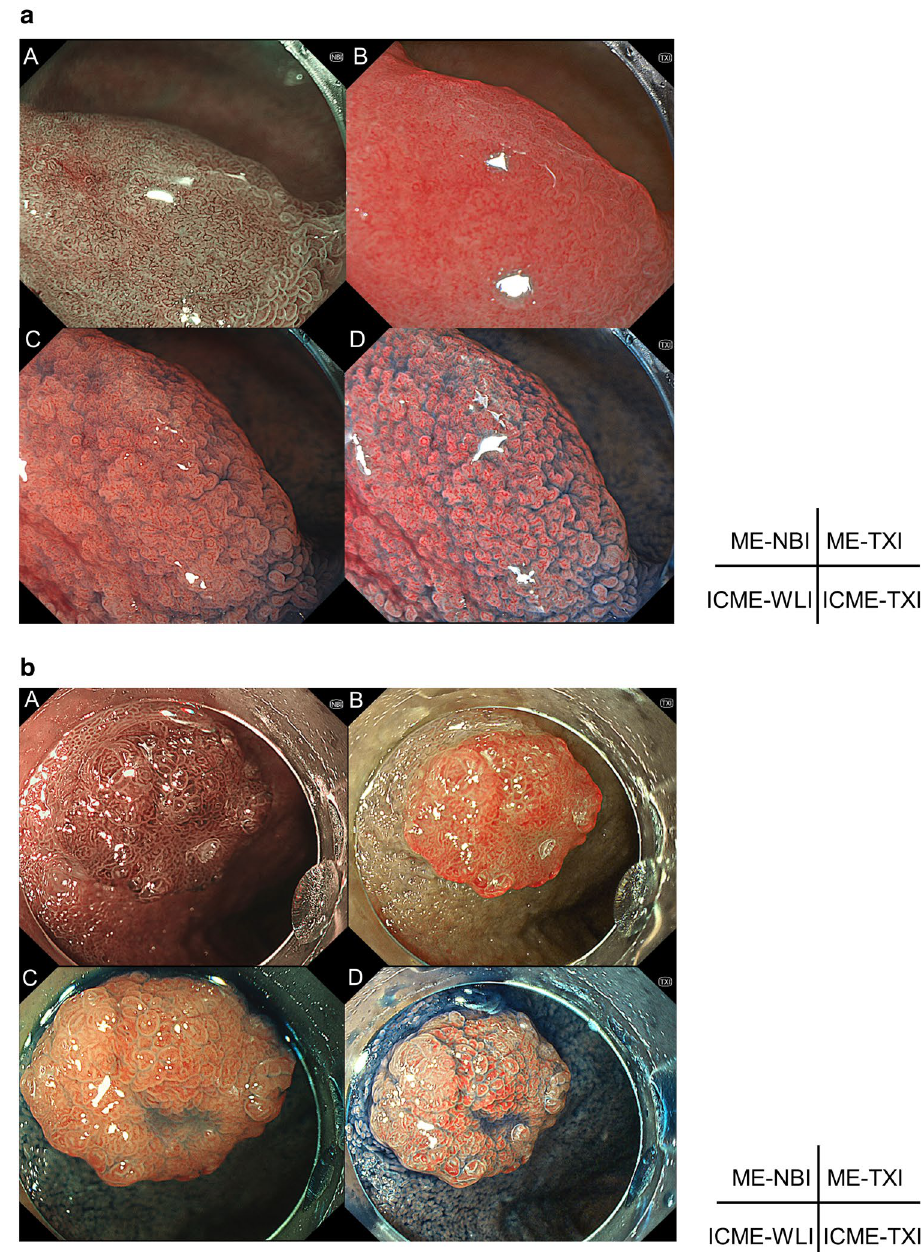
Figure 1. Representative cases of SNADETs for each modality. SNADET, Superficial nonampullary duodenal epithelial tumors; ME-WLI, magnified endoscopy with white-light imaging, ME-NBI magnified endoscopy with narrow-band imaging, ME-TXI magnified endoscopy with texture and color enhancement imaging, ICME-WLI indigo carmine dye with ME-WLI, ICME-TXI indigocarmine dye with ME-TXI, VCL Vienna classification, IMC intramucosal carcinoma. ( a ) 13 mm, IIa, pathological diagnosis of VCL C3. A. ME-NBI. B. ME-TXI. C. ICME-WLI. D. ICME-TXI. Open-loop was observed. ( b ) 10 mm, IIa, pathological diagnosis of VCL C4/5 (IMC). A. ME-NBI. B. ME-TXI. C. ICME-WLI. D. ICME-TXI. Closed-loop was